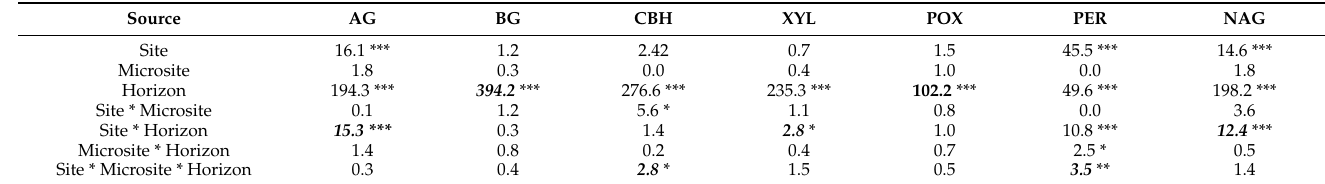
Table 2. Results (F-values and significance) of three-way ANOVA testing effects of site (natural vs. drained wetland), microsite (high vs. low from each site), and soil horizon on extracellular enzyme activity per unit mass of soil ( µ mol g soil − 1 h − 1 ) measured in soils from organic and mineral soil horizons. Bold and italicized values represent the highest level significant main effect or interaction, upon which further interpretation was based.